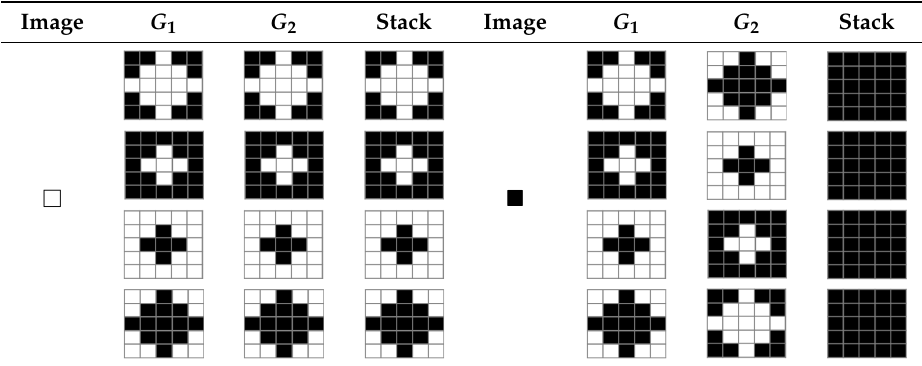
Table 6. The designed patterns for n = 6.